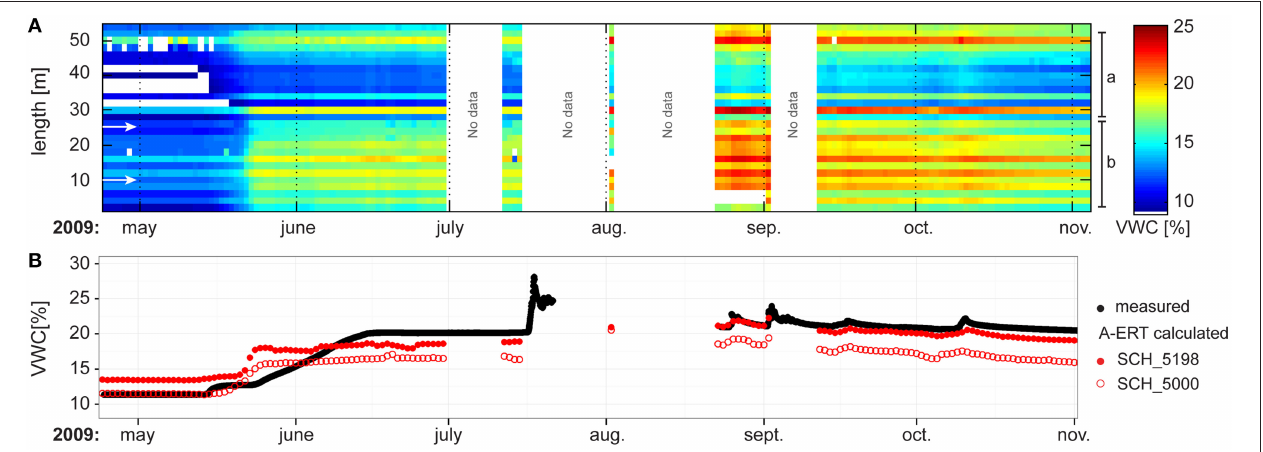
FIGURE 5 | Spatio-temporal evolution of the VWC at the surface along the A-ERT profile at Schilthorn from May to November 2009 (A), the time being displayed on the horizontal axis and the location along the A-ERT line on the vertical one. The arrows indicate the locations of the two boreholes (SCH_5198 = 10m and SCH_5000 = 26m). (B) compares the temporal evolution of measured (FDR) and calculated (Archie) values at the location of the two boreholes. The zones a and b mentioned in the text are indicated on the right hand side of (A) .